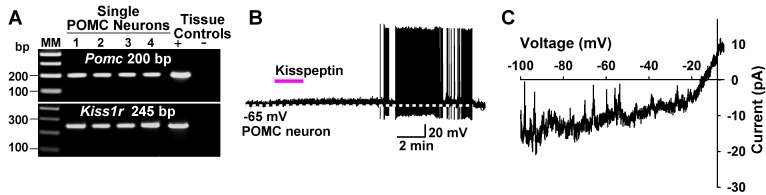
Kisspeptin excites POMC neurons by activating a non-selective cation conductance.(A) representative gel illustrating the scRT-PCR expression of Kiss1r (GPR54) transcript in POMC neurons. (B) kisspeptin (200 nM) depolarized and increased firing of POMC neurons (n = 8). (C) I/V (digital subtraction of control I/V from I/V with kisspeptin using a Cs+-based internal solution; see Materials and Methods) showed that kisspeptin activated a non-selective cationic channel that reversed at −10 mV.